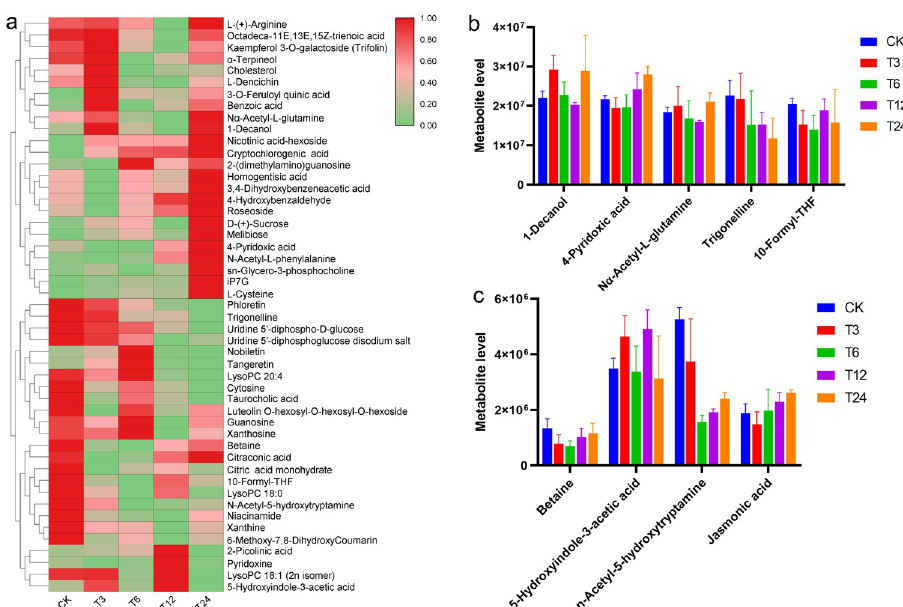
Fig 4. Content of differential metabolites. (a). The levels of differential metabolites. The redder the color, the higher level of differential metabolites. (b). The contents of the five differential metabolites with the highest abundance. (c). The content of key differential metabolites screened according to KEGG enrichment